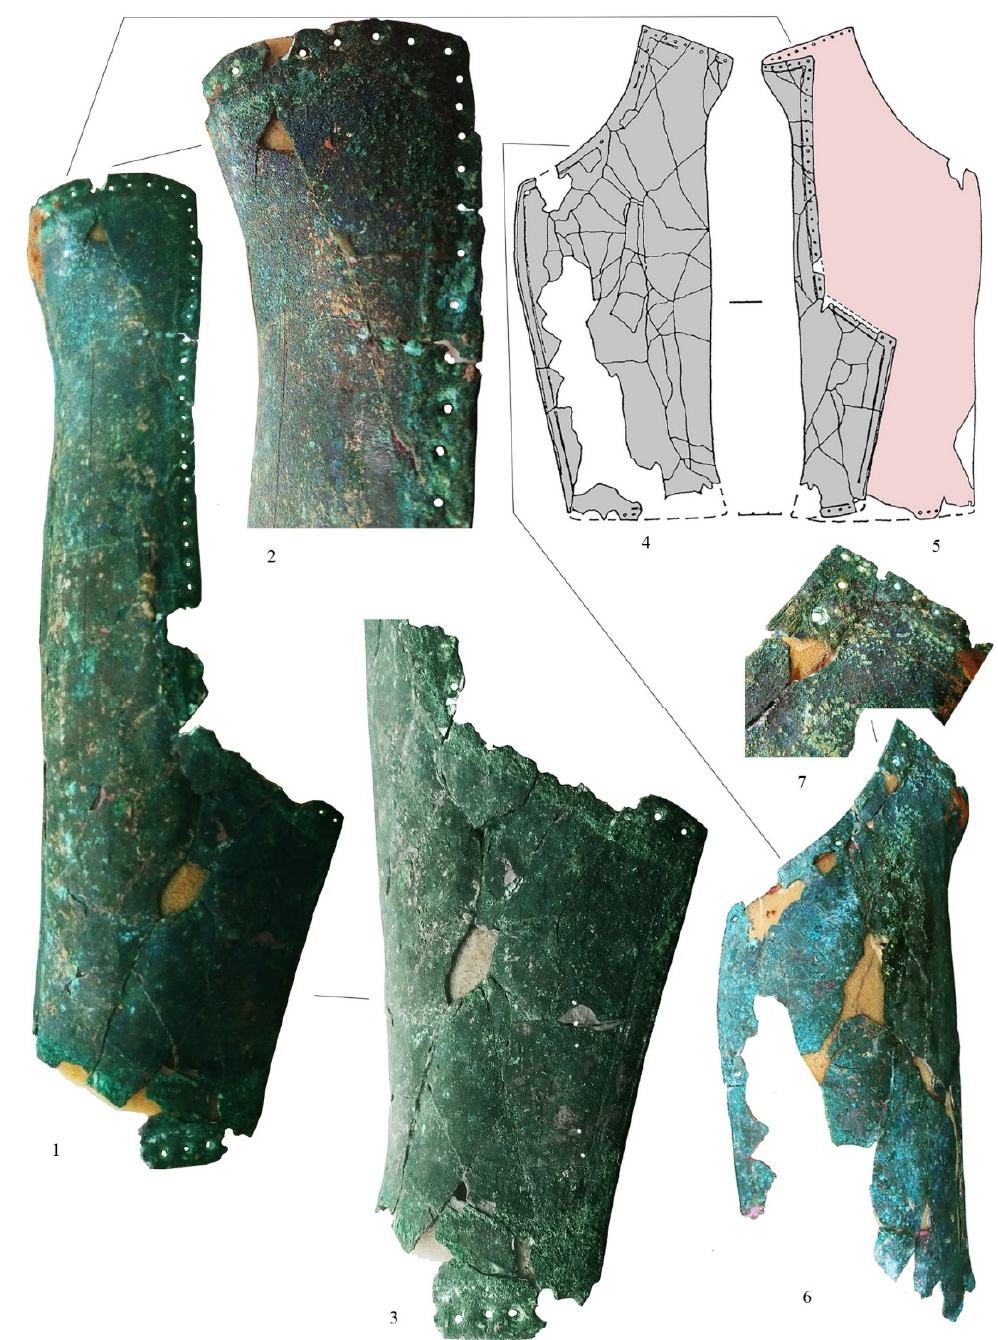
Figure 12. Greaves from Soboleva Mogyla Burial 2. (1)–(5)—The right greave. (6)–(7)—The left greave ((1)–(3), (6), (7)—photograph М . Daragan.) (5)—Drawing (after: Mozolevskiy and Polin 2005, fig. 104: 10–11).